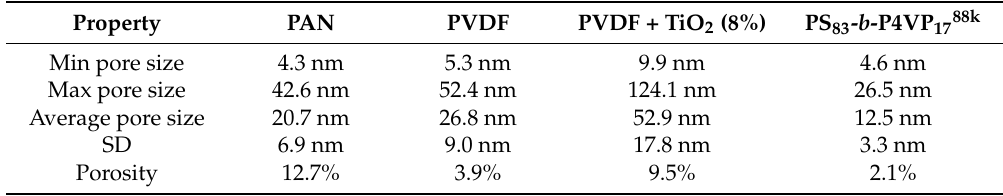
Table A1. Summary of pore size distribution measured by software on SEM images of different support membranes (PAN, PVDF and PVDF + TiO 2 (8 wt.%)) and a PS 83 - b -P4VP 1788k _DOX 1001 on PAN membrane with 15 s evaporation time.